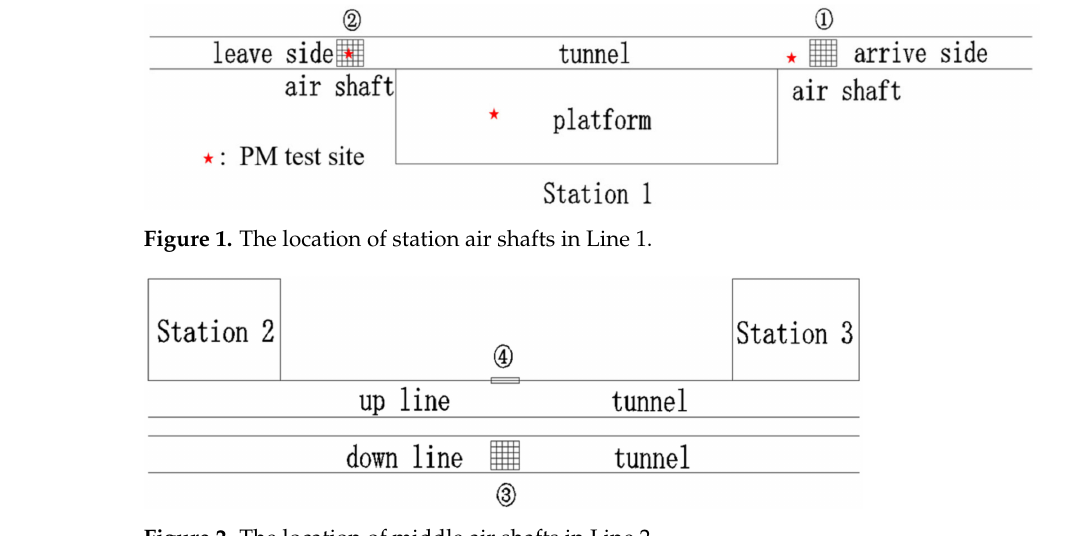
Figure 2. The location of middle air shafts in Line 2.